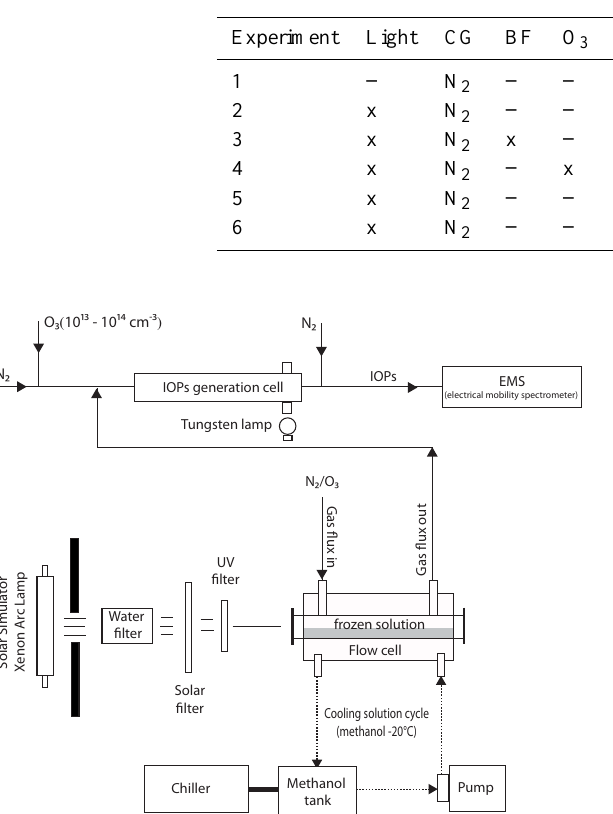
Table 1. IOP (iodine oxide particle) production experiment conditions and results. IOP mass productions are expressed as gcm − 3 measured for 180min (3h). Abbreviations: Light – solar simulator, CG – carrier gas, BF – blue filter, O 3 – ozone in the flow cell, RC – reaction cell, Sol – solutions (W: water, HA: humic acid), an “x” represents an active parameter while “—” represents an inactive parameter.